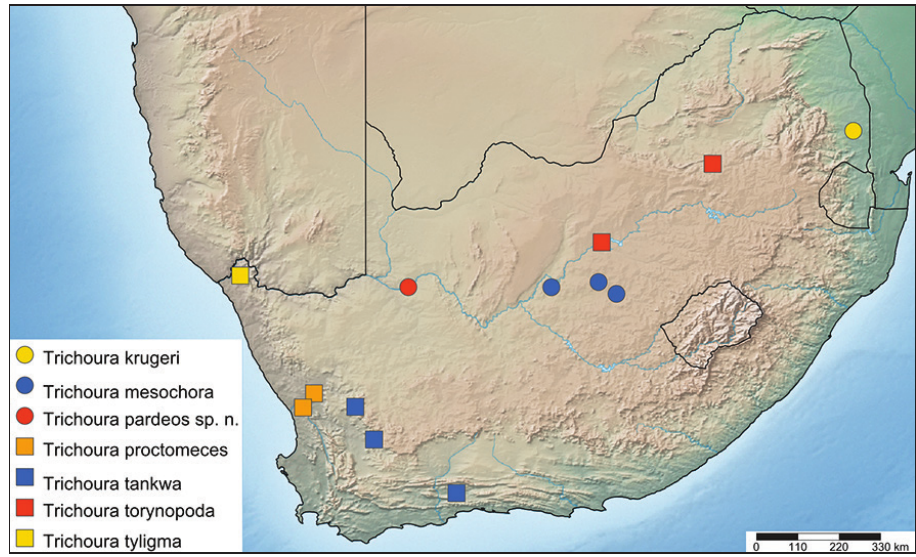
Figure 20. Map of South Africa with elevational relief and distribution of Trichoura species. (SimpleMappr 6129 -